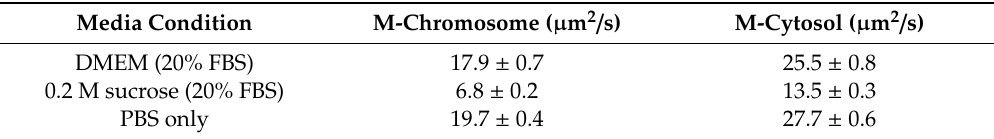
Table 3. Summary of di ff usion coe ffi cients ( D ) of mGFP in mitotic chromosomes and cytosol of